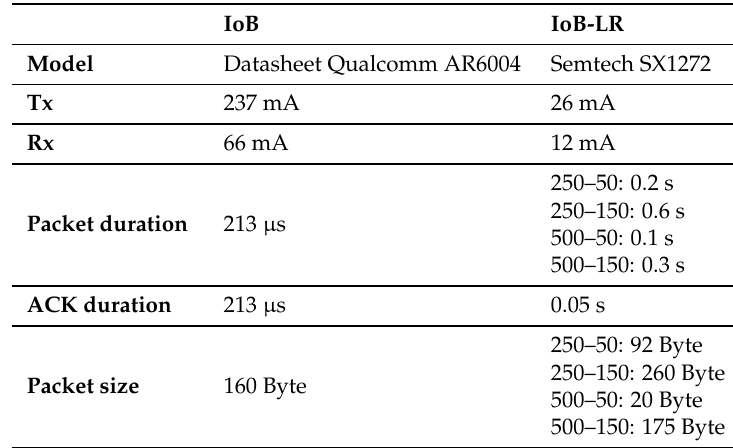
Figure 19. Airtime for different SF and payloads [50]. Table 3. Parameters used in our theoretical results.